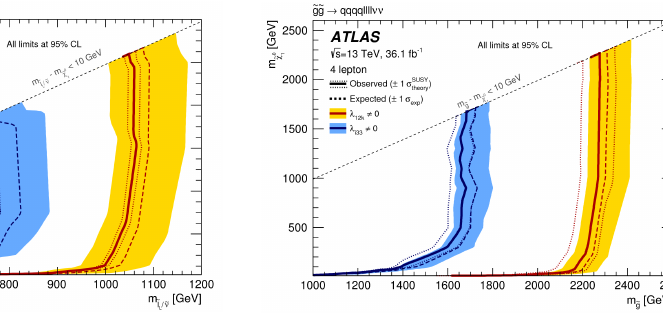
Figure 25: RPV ˜ l / ˜ ν NLSP [ 21 ] . Figure 26: RPV ˜ g NLSP [ 21 ]